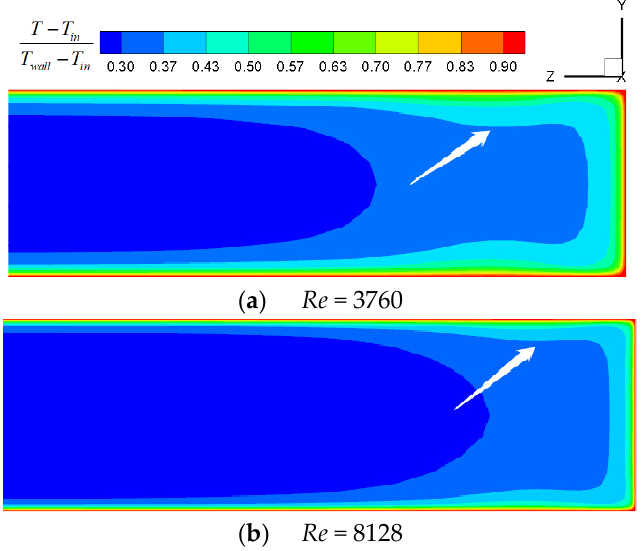
Figure 18. Nondimensional temperature contours on the middle cross section.